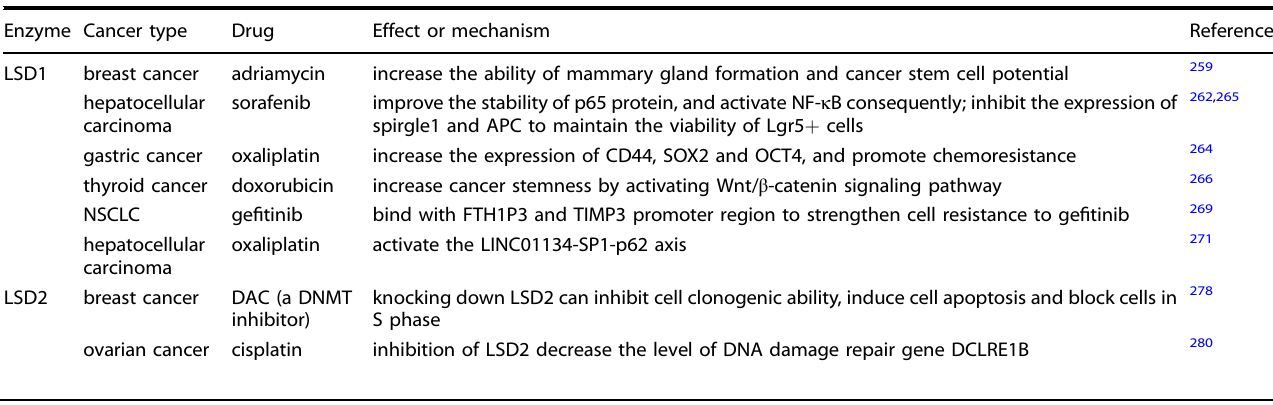
Table 2. Effect of LSD family on drug resistance Enzyme Cancer